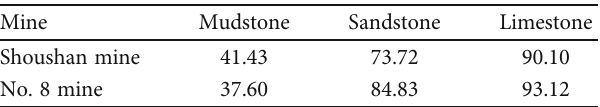
Figure 3: Contour map of the fault fractal dimension. Table 3: Compressive strength of each lithology test in the study area (MPa).